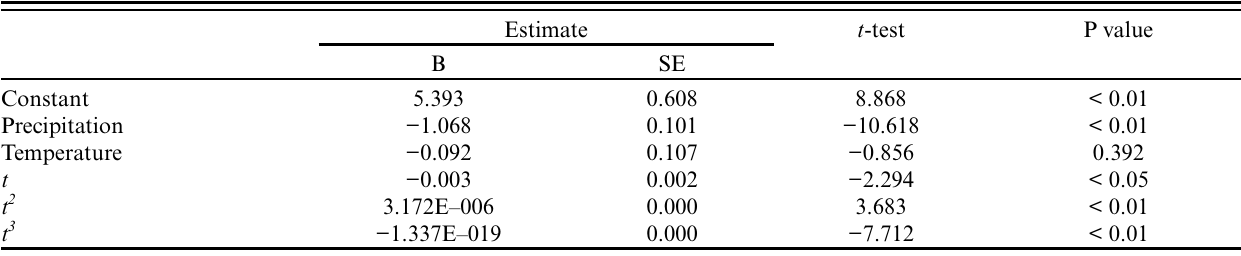
Table 2 . Regression analysis of climate change and nomadic migration.